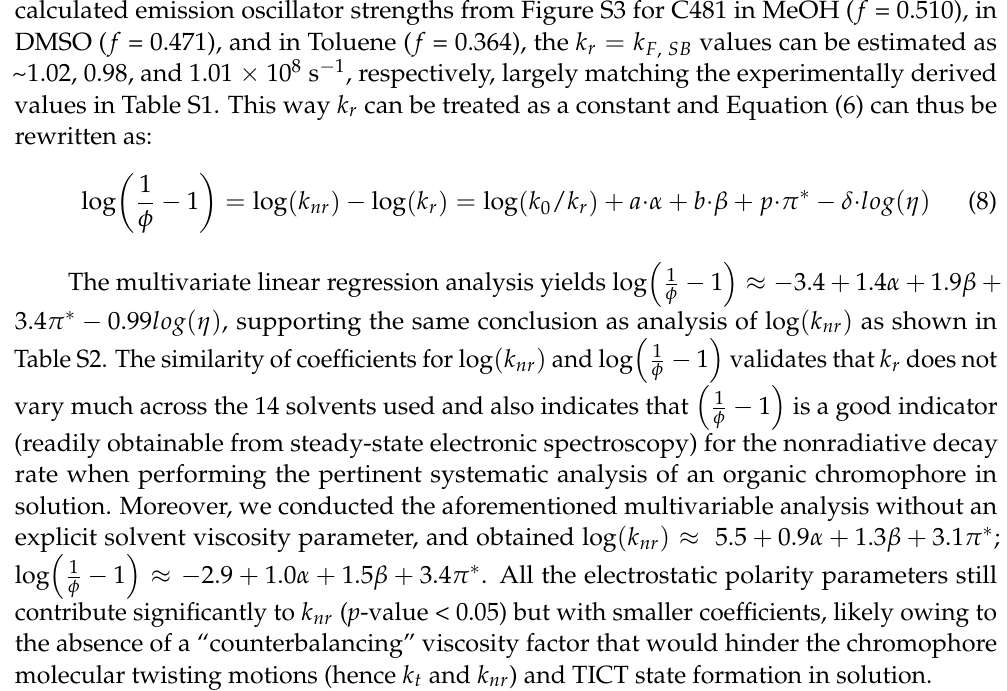
explicit solvent viscosity parameter, and obtained log ( k nr ) ≈ 5.5 + 0.9 α + 1.3 β + 3.1 π ∗